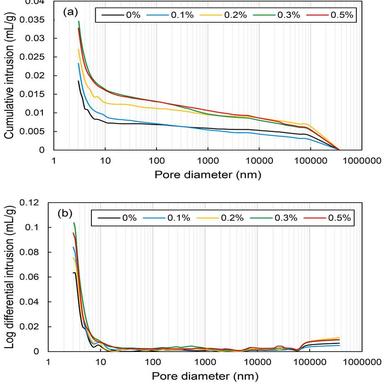
(a) Cumulative pore volume and (b) logarithmic derivative of the samples at 28 d of curing.